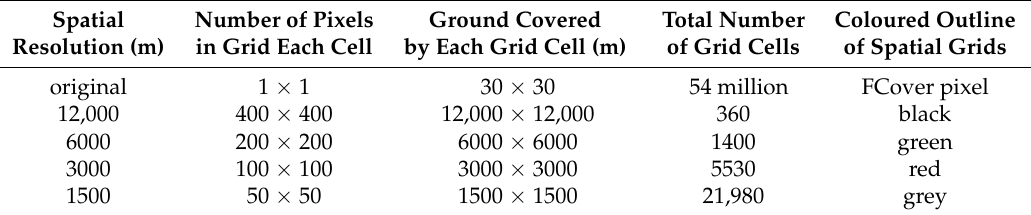
Table 1. Table of proposed data reduction scheme. The table shows the smallest resolution of 12,000 m up to the largest resolution of 1500 m and resulting total number of spatial grid cells used for the following spatial aggregation steps. By proposing our data reduction scheme we are not dealing with the original number of 54 million pixels per FCover scene organised in about 7000 rows and 8000 columns.